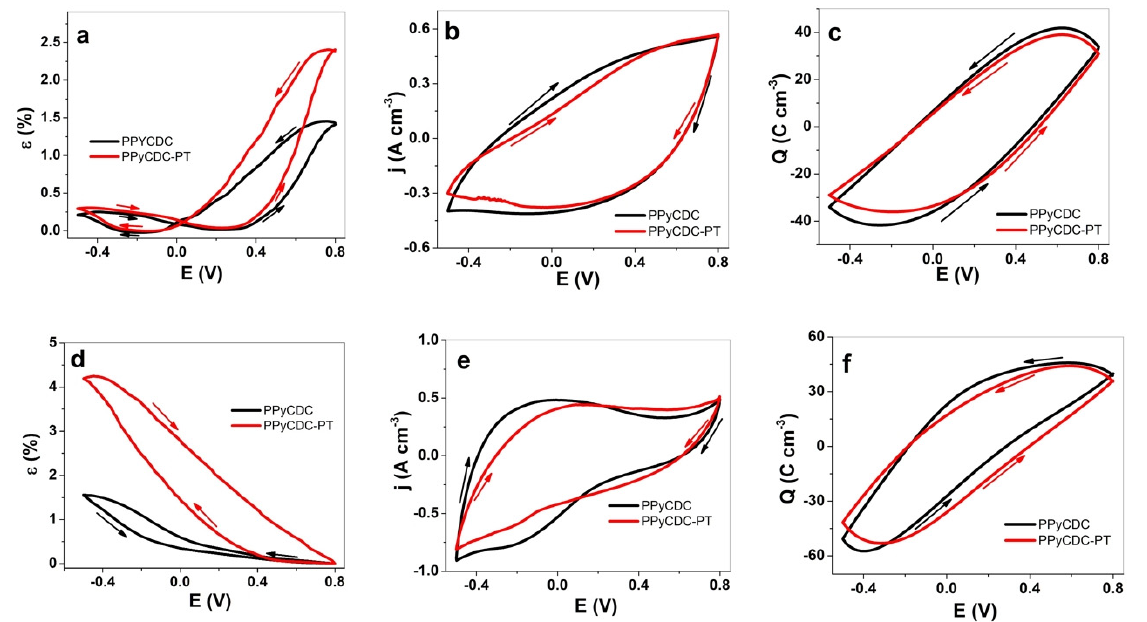
Figure 4. Cyclic voltammetry (scan rate 5 mV s − 1 ) of PPyCDC (black line) and PPyCDC-PT (red line) films investigated in LiTFSI-PC electrolytes, showing ( a ) strain ε , ( b ) current density j, and ( c ) charge density Q against potential E (0.8 V to − 0.5 V). The films used in LiTFSI-aq are presented with ( d ) strain, ( e ) current density j, and ( f ) charge density Q in the same potential range E. The arrows represent the start and end of the 3rd